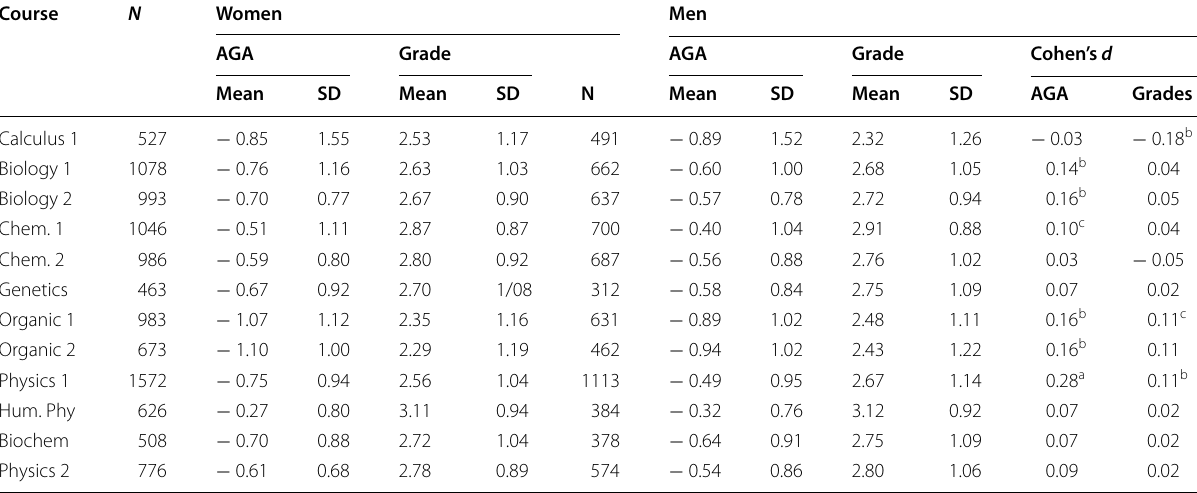
A bold Cohen’s d signifies that a t test showed significant differences between men and women. The following abbreviations are used: Human Physiology (Hum. Phy.), Biochemistry (Biochem.), Organic Chemistry (Organic), and Chemistry (Chem) a indicates that p < 0.001 b indicated that p < 0.01 c indicates p < 0.05